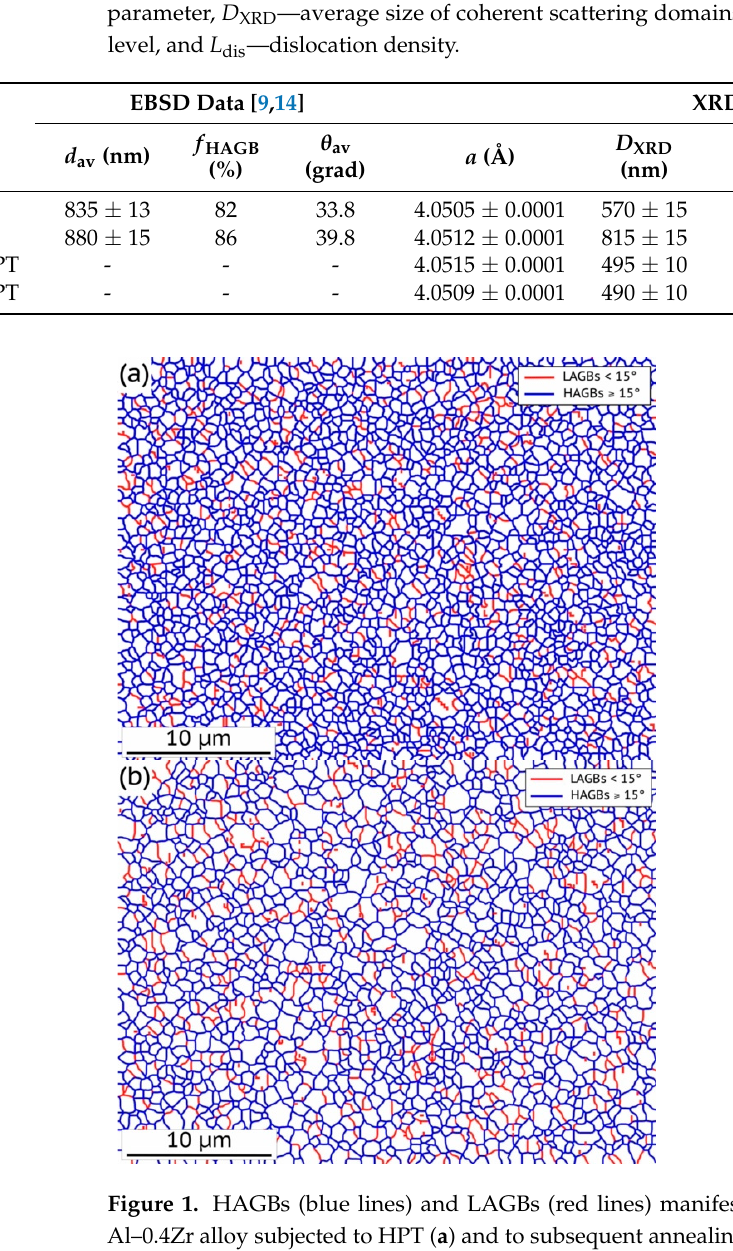
Table 1. Microstructure characterization results for Al–0.4Zr alloy in different structural states;